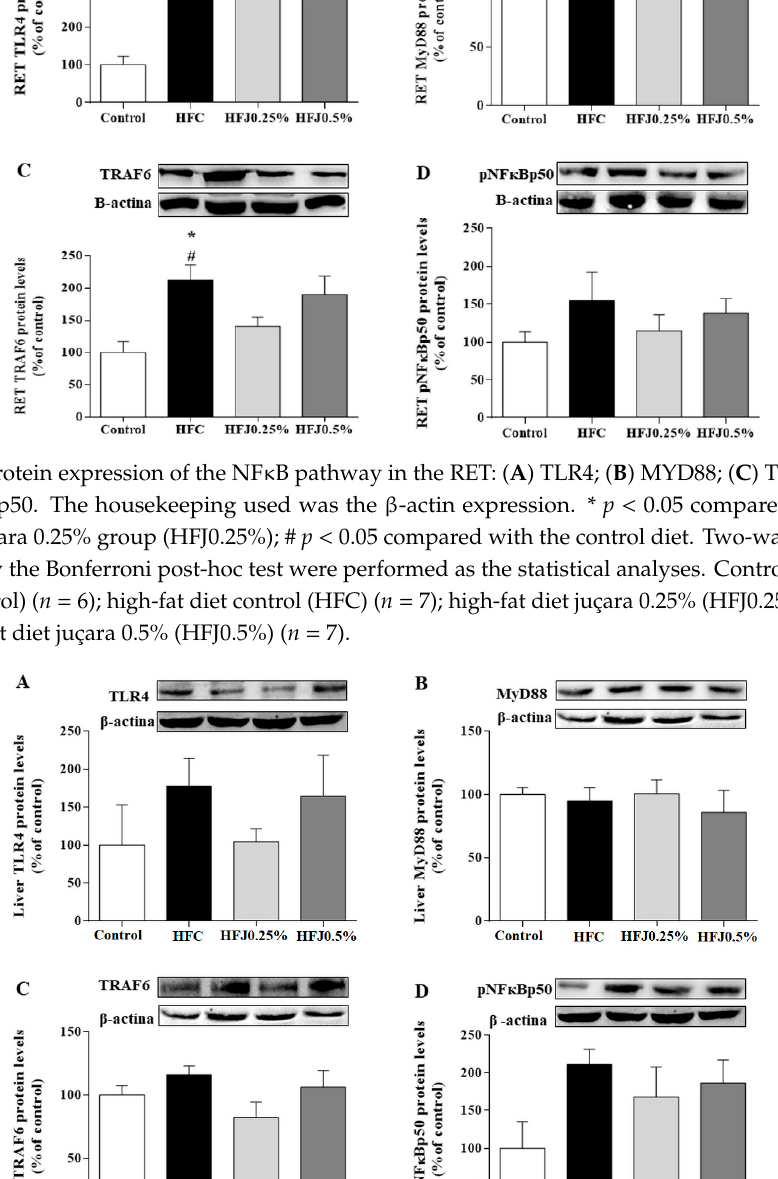
Figure 4. Protein expression of the NF κ B pathway in the RET: ( A ) TLR4; ( B ) MYD88; ( C ) TRAF6; and